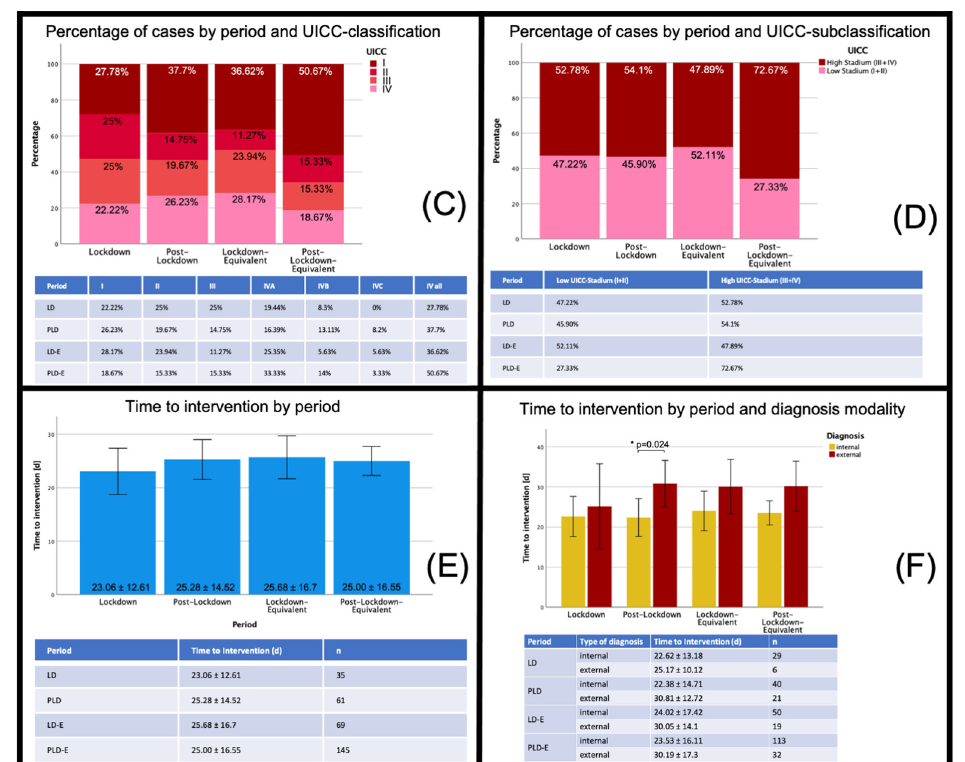
Figure 4. Data sheet Medical Department Berlin: Distribution of patients with oral malignant lesions by different periods, distribution of tumor stages (T-classification, UICC-classification) and time to intervention during the different periods.